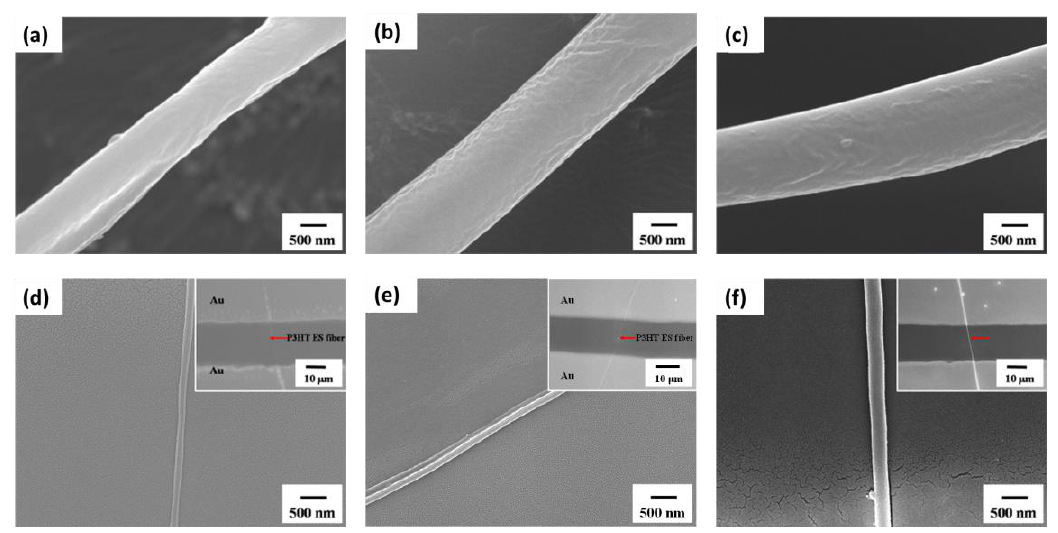
Figure 4. Scanning electronic microscopy (SEM) images of as-spun P3HT/PMMA fibers prepared